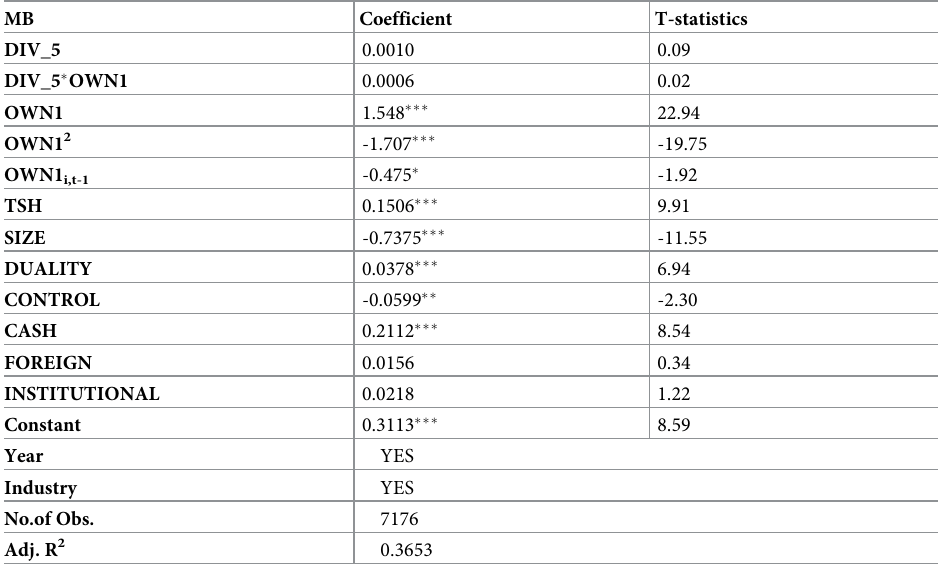
Table 9. Robustness test: Controlling for the succession period of OWN1 in PFs.